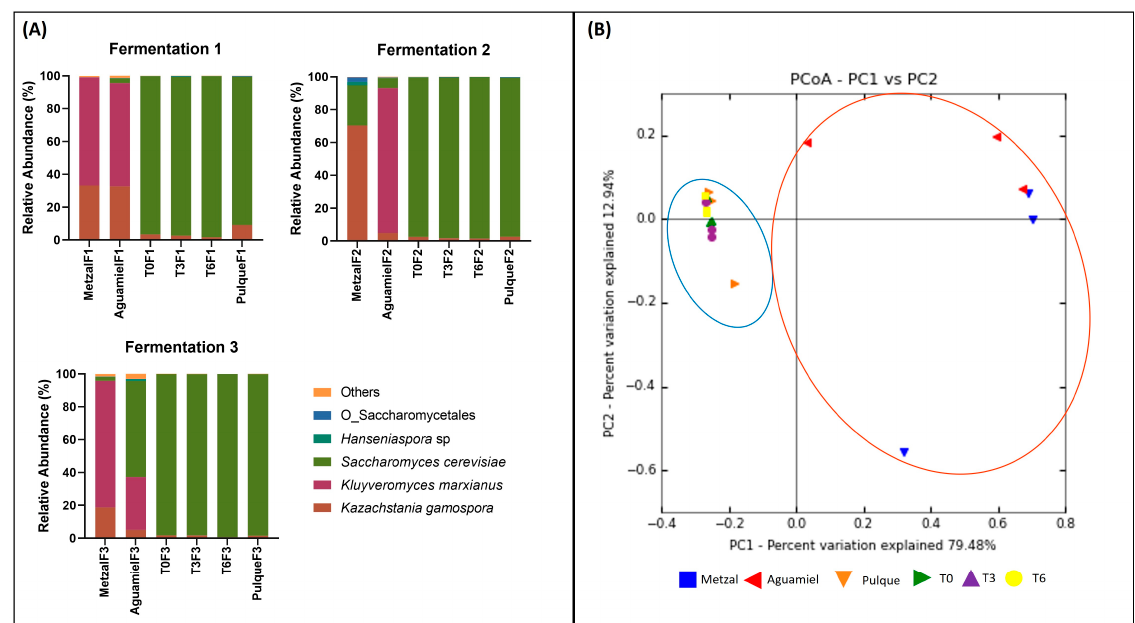
Figure 5. Fungi diversity during pulque fermentation. ( A ) The relative abundance profile of fungi is shown for each of the three fermentations using UNITE 2021 database. ( B ) Fungi PCoA plots based on the Bray–Curtis analysis. The blue circle represents an association between the samples. The graphs represent the microorganisms with more than 0.01% of relative abundance. The complete relationship of those microorganisms included in the group Others is shown in the Supplementary Files (Table S2). The diversity indexes calculated for fungi indicated that AM showed the highest di- versity, followed by metzal. During the fermentation stages, the fungal diversity re- mained practically constant (Table 2). In AM, Observed_otus AM = 20.66, Chao1 AM = 21.66, H AM = 1.26, and D AM = 0.44. The fungal core was composed of K. marxianus (61.03%), S. cerevisiae (22.62%), K. gamospora (14.21%), Hanseniaspora sp. (0.45%), and O_Saccharomy- cetales (0.13%). In metzal, Observed_otus MZ = 15.66, Chao1 MZ = 16.77, H MZ = 1.09, and D MZ